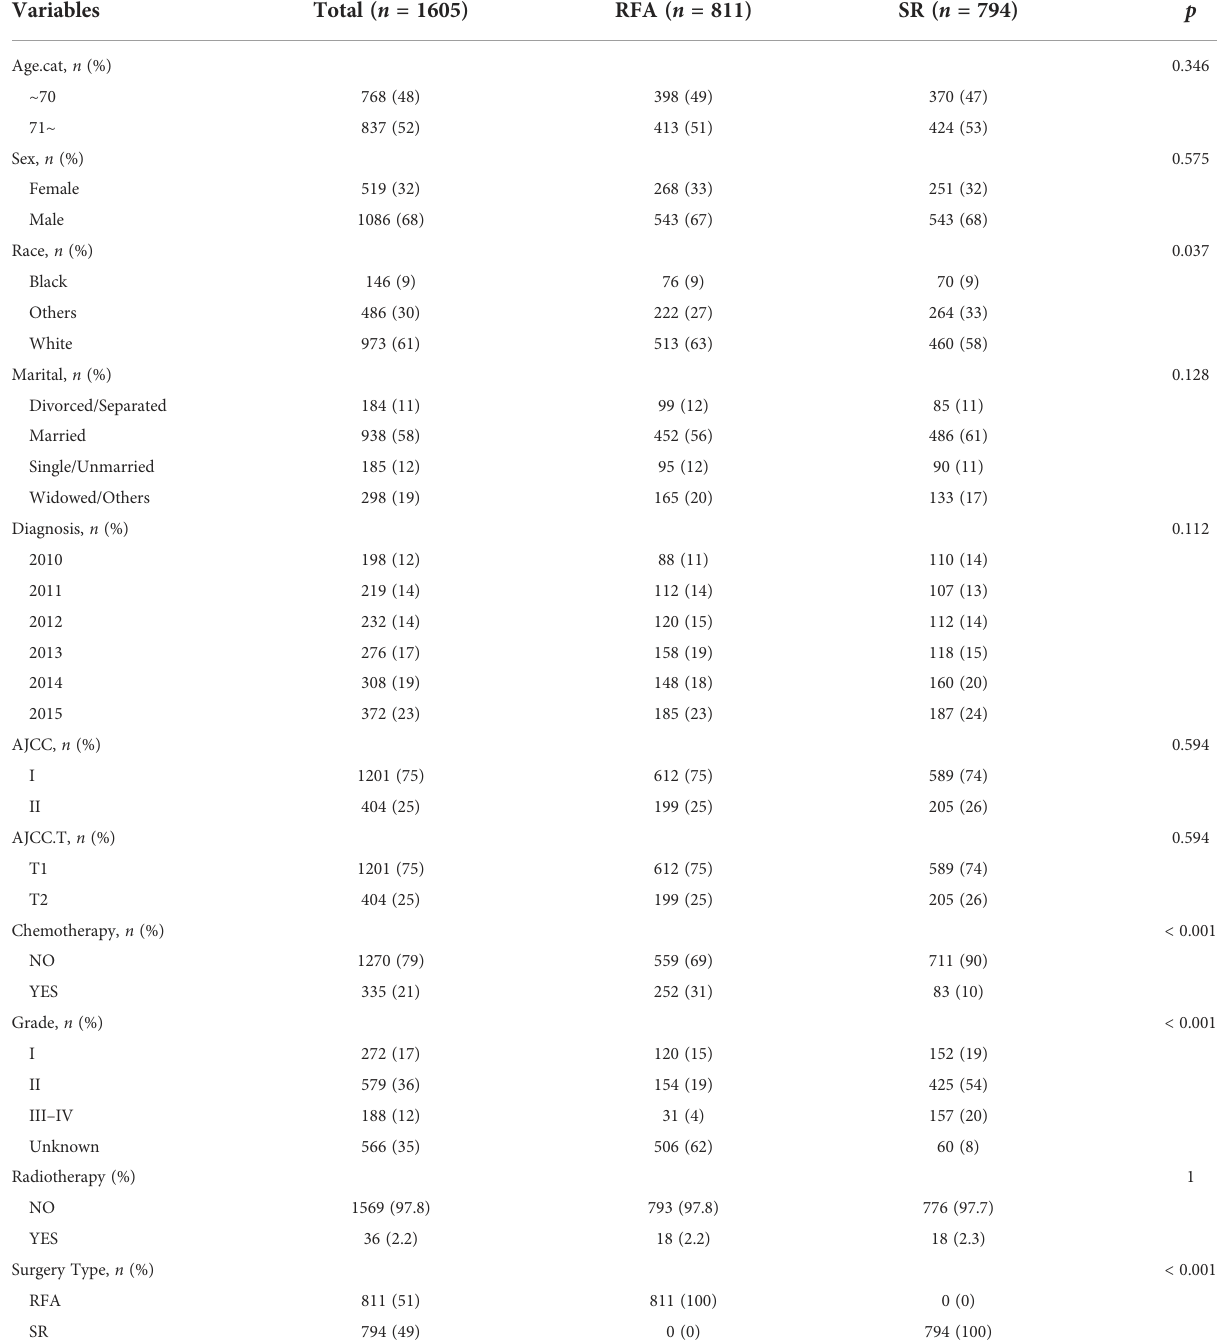
TABLE 1 Baseline characteristic of the included primary HCC patients in the SEER